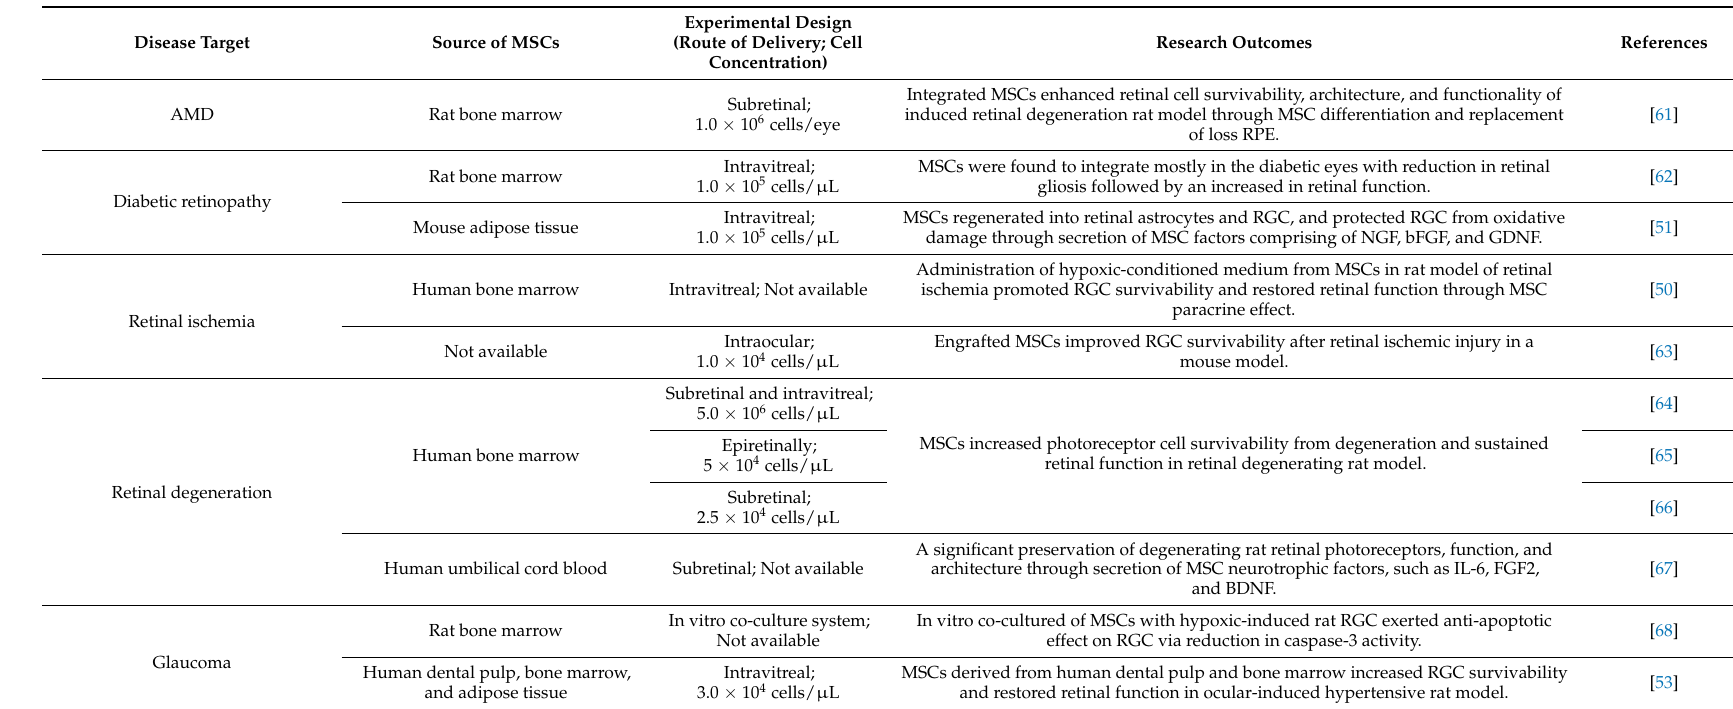
Table 1. Recent pre-clinical studies MSCs for the treatment of retinal